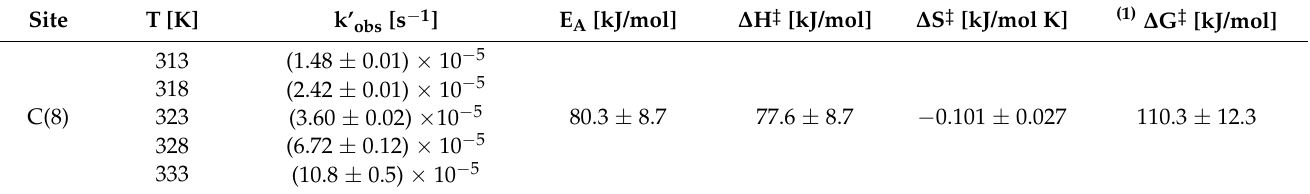
Figure 7. 1 H-NMR kinetics data for H/D exchange at C(8) by D 2 O at five different temperatures in quercetin 3 in D 2 O/DMSO d6 1:1 solution. Table 2. Kinetic data for H/D exchange at C(8) by D 2 O in quercetin 3 (D 2 O/DMSO d6 1:1 mixture). Site